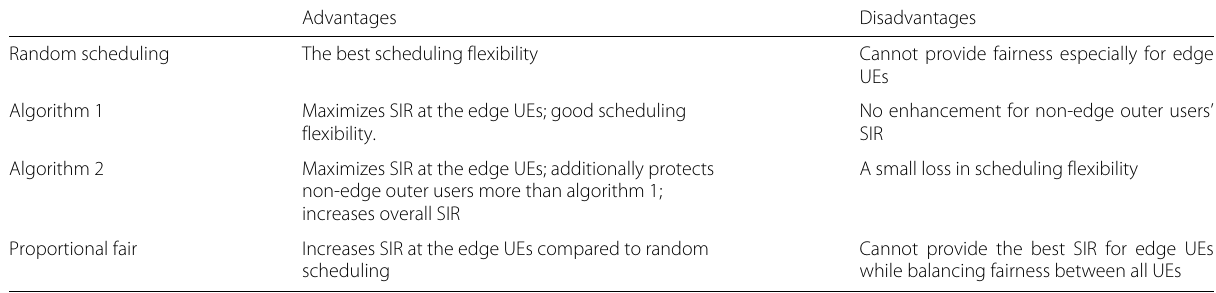
Table 3 Basic comparison of the